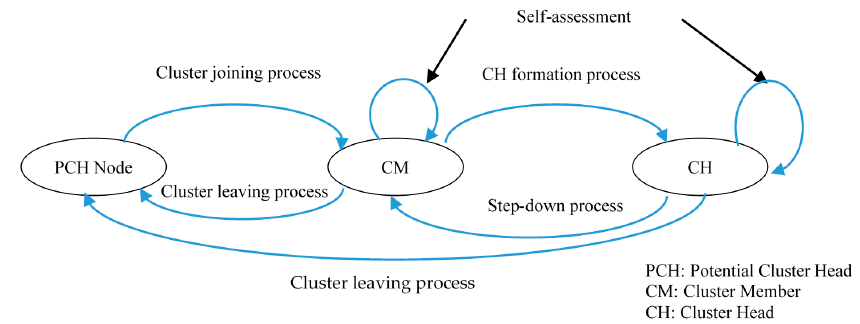
Figure 3. States of CR-WS potential cluster head (PCH) nodes.